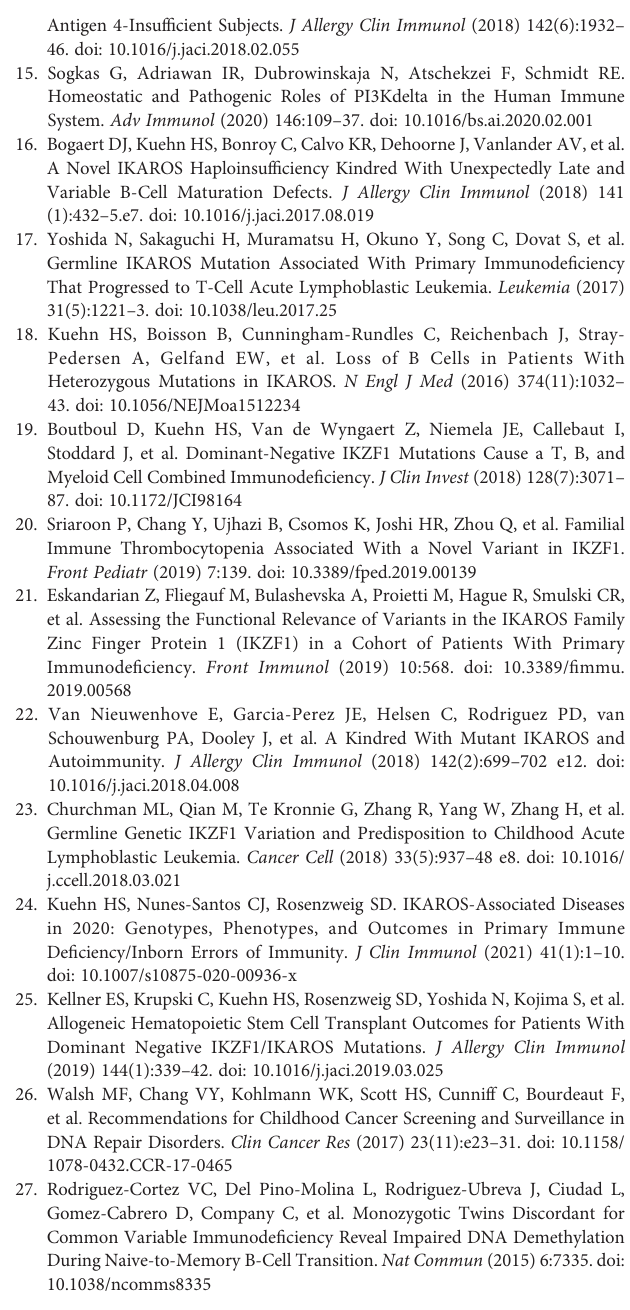
Supplementary Figure 1 | (A) Percentages of naive (CD27 + CD45RA + ), memory (CD27 + CD45RA - ) and effector memory T cells (CD27 - CD45RA + ) within total CD4 + and CD8 + T cell pool. (B) Surface IgM, IgG and IgA expression ex vivo in the index patient and